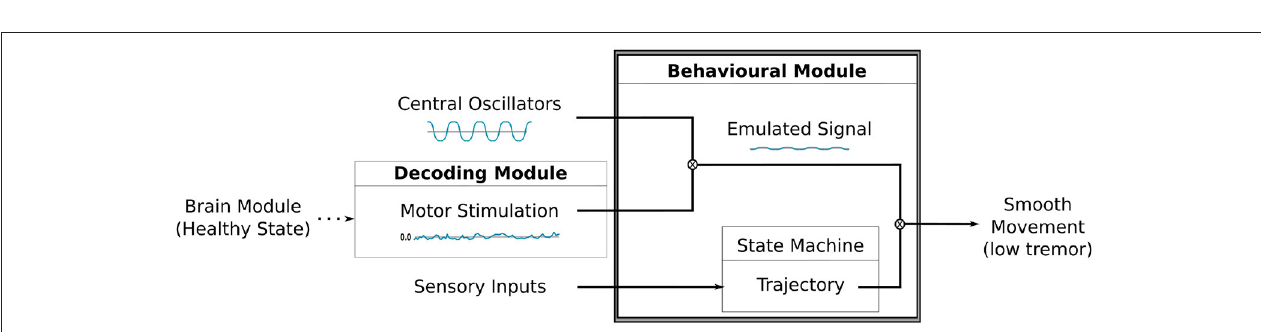
FIGURE 4 | Full diagram showing the robot sensorimotor loop. The robot adjusts the sensory inputs from the environment through the Encoding Module (EM). The sensory information is then propagated throughout the Brain Module (BM) affecting the dynamics of the cortical neurons which are used to adjust the robot’s movements. The dynamics of cortical neurons are decoded to motor stimulation by the Decoding Module (DM), then it is used to modulate the oscillatory signal received from the central oscillators inside the behavioural Module (BeM). The BeM then translates all these signals into motor commands with certain level of disturbance.